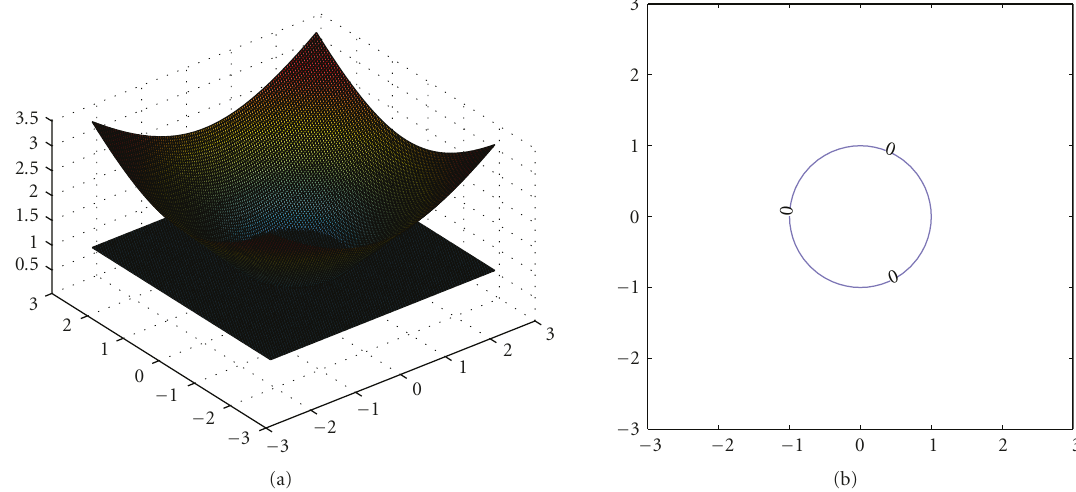
Figure 1: The level set (a) evolution function and (b) the curve obtained with zero level of the level set function.